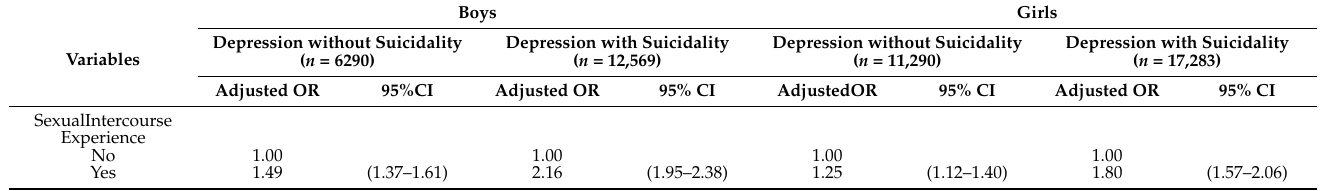
Table 4. Subgroup analysis of the association between depression with/without suicidality and sexual